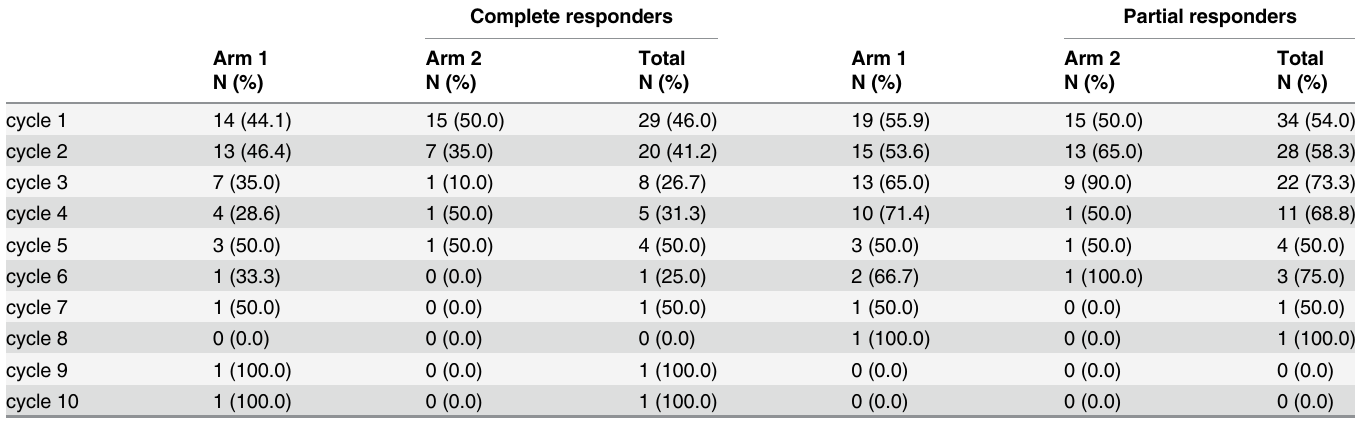
Table 3. Completion of HRQoL questionnaire at each follow-up measurement time according to treatment arm and missing data